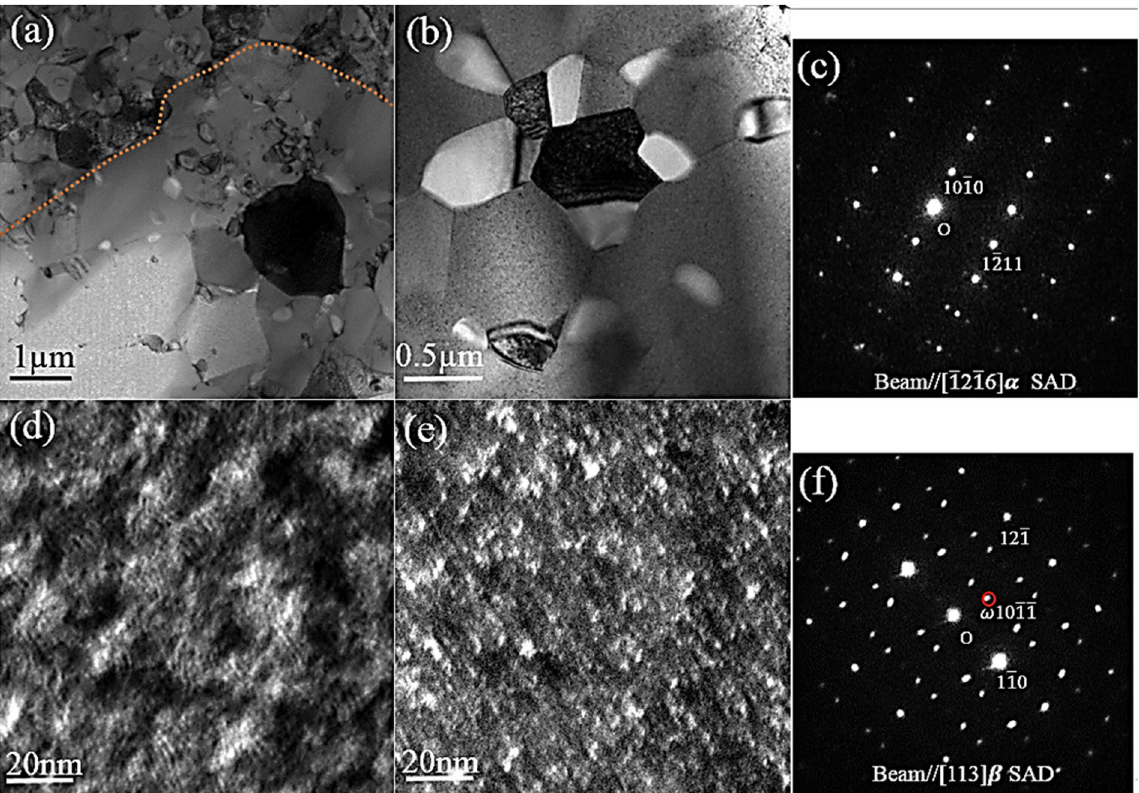
Figure 3. TEM analysis of 820–5 M alloy. ( a ) BF-TEM micrograph taken from the interface between the nanometer-grained region and micrometre-grained region. ( b ) BF-TEM micrograph taken from the nanometer- grained duplex region. ( c ) SAED pattern taken from the grain exhibiting darkest contrast in ( b ). ( d ) High magnification BF-TEM micrograph and its corresponding DF-TEM micrograph ( e ) taken from the bottom-right dark grain in ( a ). ( f ) SAED pattern on [113] β zone